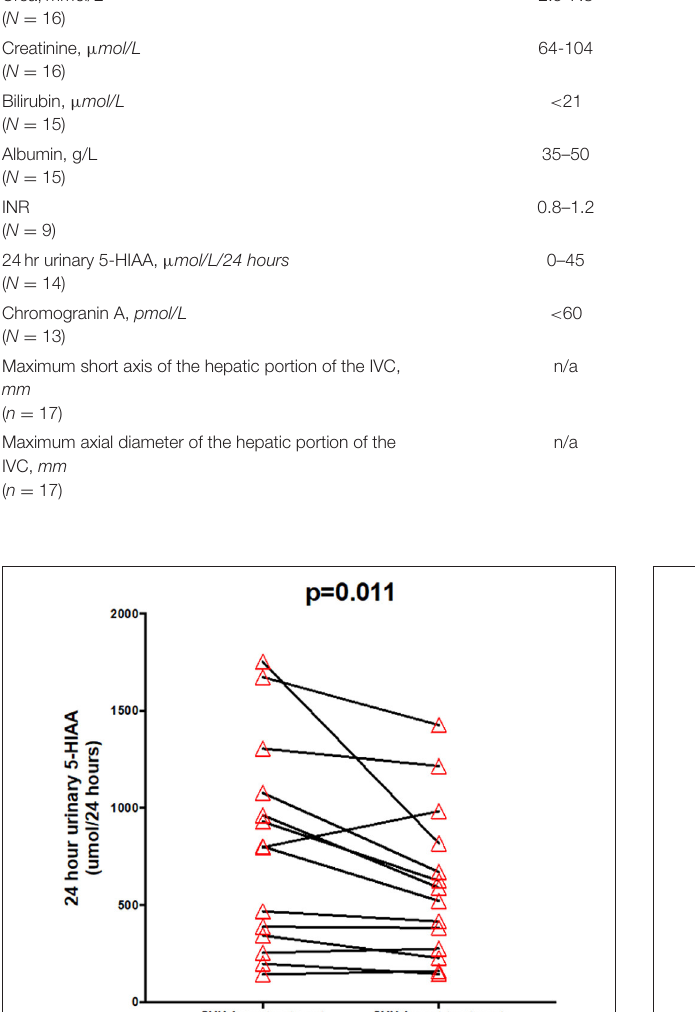
FIGURE 5 | Serum chromogranin A pre- and